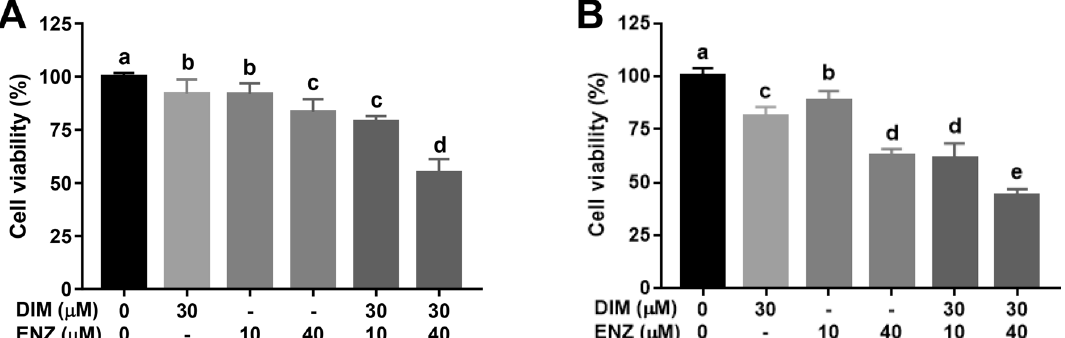
Figure 1. Inhibition of cell proliferation by DIM (30 μM) and ENZ (10 or 40 μM), alone and in combination, in 22Rv1 cells at 48 h ( A ) and 72 h ( B ) post-exposure (n = 6). DIM 3,3 ′ -diindolylmethane; ENZ enzalutamide. Values are presented as means ± SD. a,b,c,d Bars without the same letters at the top indicate statistically-significant differences between treatments when compared with each other (one-way ANOVA, Duncan’s new multiple range test, p <